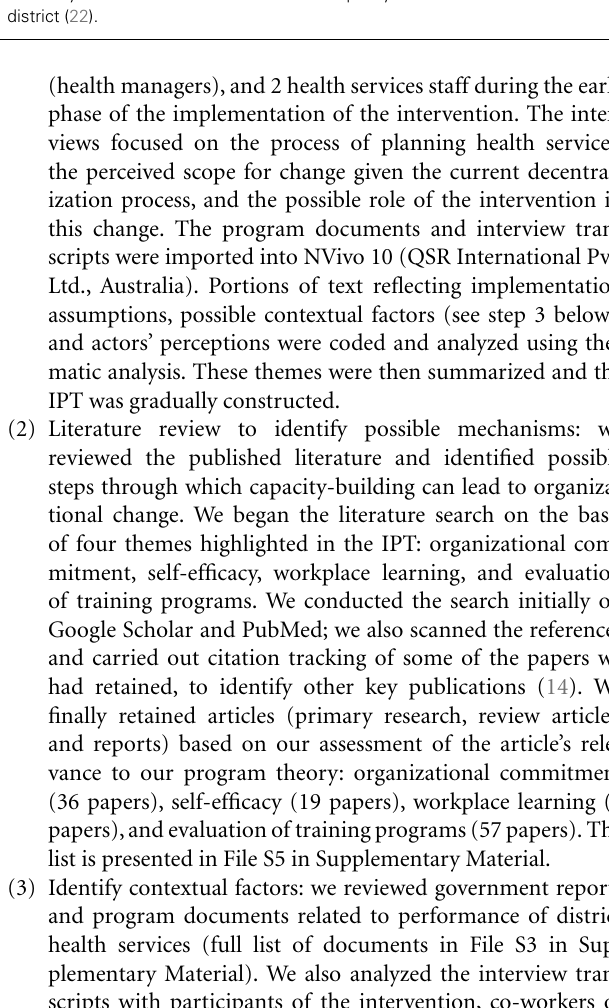
FIGURE 1 |A generic representation of an intervention and its interaction with the district health system and its various sub-units (Su) . Sub-units could include hospitals, disease-control programs, or talukas (sub-districts). A